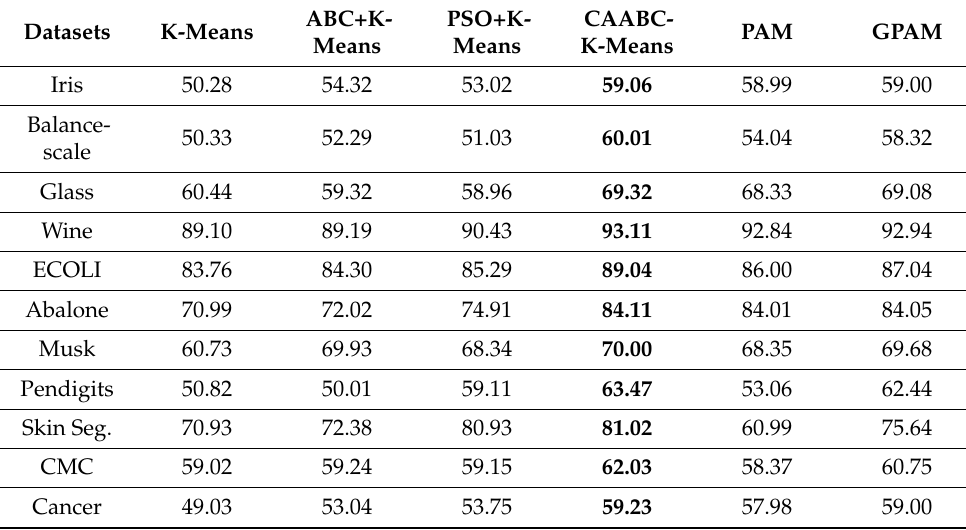
Table 7. The Accuracy for classifying the eleven training datasets.